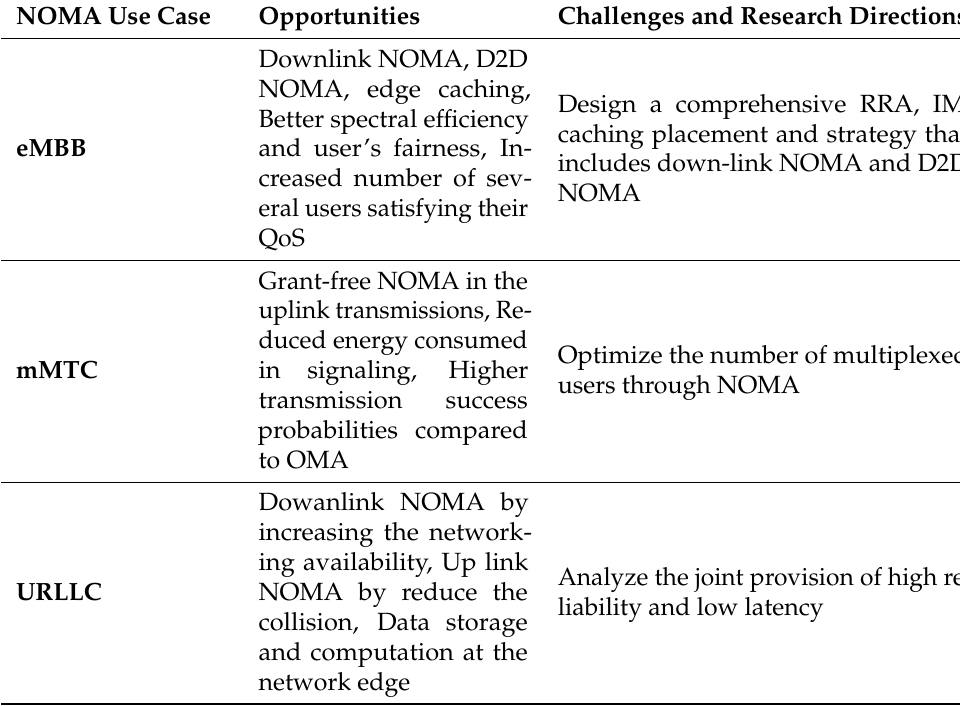
Table 2. Integration of NOMA in different radio access network